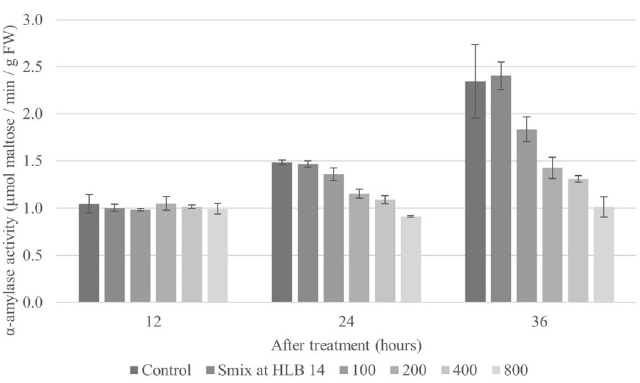
Figure 8. The effect of the optimized CEO nanoemulsion on α-amylase activity of E. crus-galli seeds at 12, 24, and 36 h. Error bars represent standard deviation of the